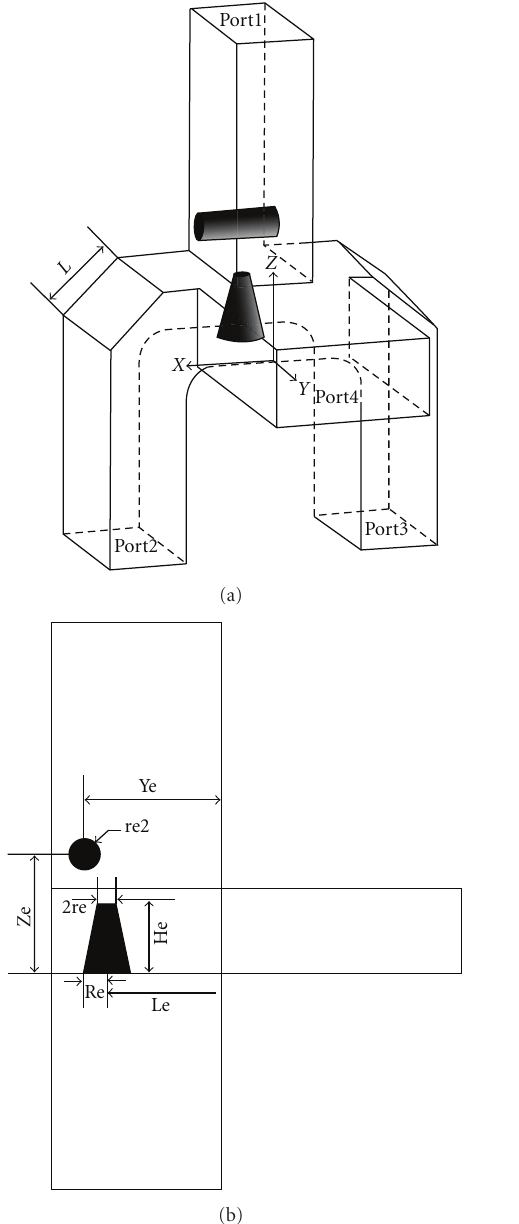
Figure 1: E-face-folded magic-T (a) geometry (b) parameters configuration.